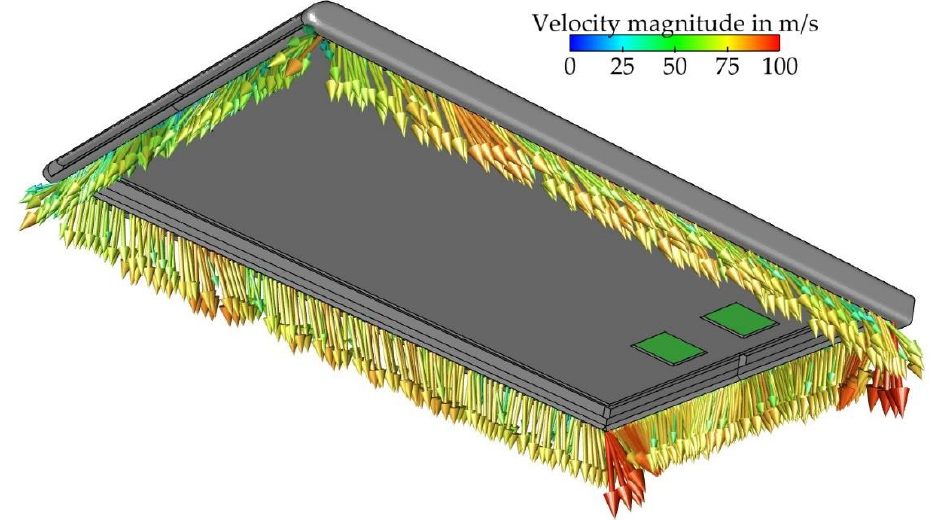
Figure 13. Velocity vectors at curtain nozzles, seen from the bottom, on a half part of the shell object traveling at speed of 40 m/s.